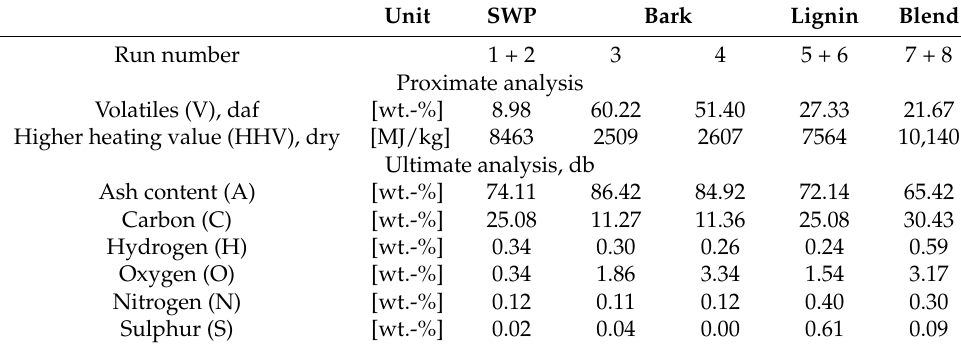
Table 4. Physicochemical analysis of chars from the second stage cyclone. Unit SWP Bark Lignin Blend Run